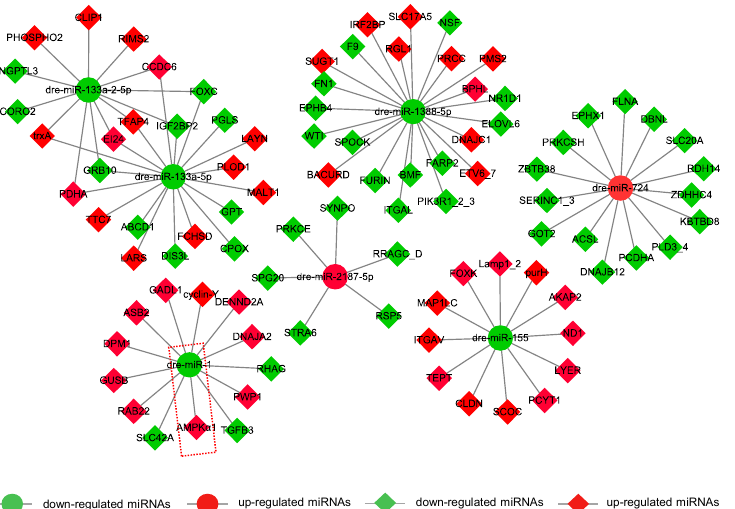
Figure 6. mRNA-miRNA integrate analysis reveals miR-1 and AMPK were involved in hypothermia exposure. Sig-diff miRNAs were selected to conduct mRNA-miRNA integrate analysis, and DEGs were targeted as the background. Data retrieved from high-throughput sequencing were applied to the integrated network by Cytoscape 3.7.2. The red dotted box represents there was a targeting relationship between miR-1 and AMPK α 1.